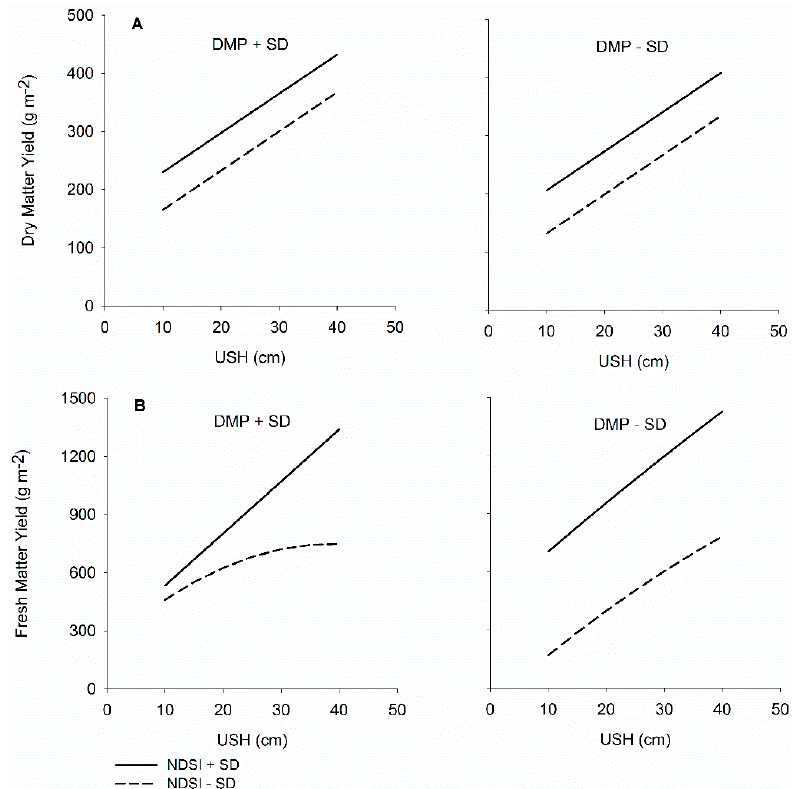
Figure 5. Predictions of dry matter yield (DMY) ( A ); and fresh matter yield (FMY) ( B ) in common swards based on ultrasonic sward height (USH) and the Normalized Difference Spectral Index (NDSI) as influenced by dead material proportion (DMP) in the range of ± standard deviation (SD). NDSI represents narrow-band reflection values selected in combination with USH for each parameter.